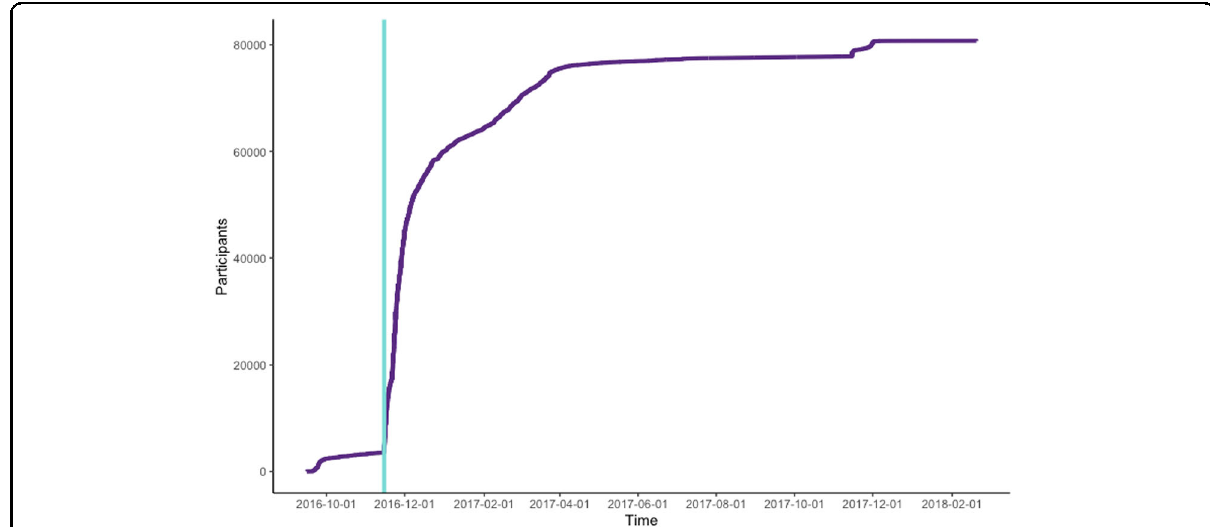
Fig. 3 Participant enrollment over the recruitment period. The light green line represents the end of the pilot period and the initiation of nationwide